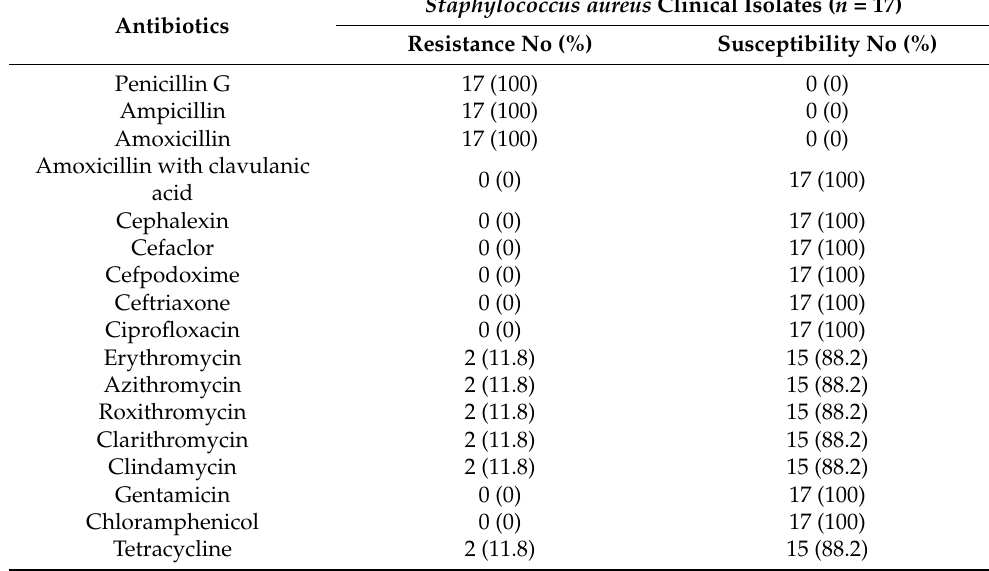
Table 5. Antibiotic susceptibility among Staphylococcus aureus isolates from palatine and adenoid tissue (disk diffusion method,